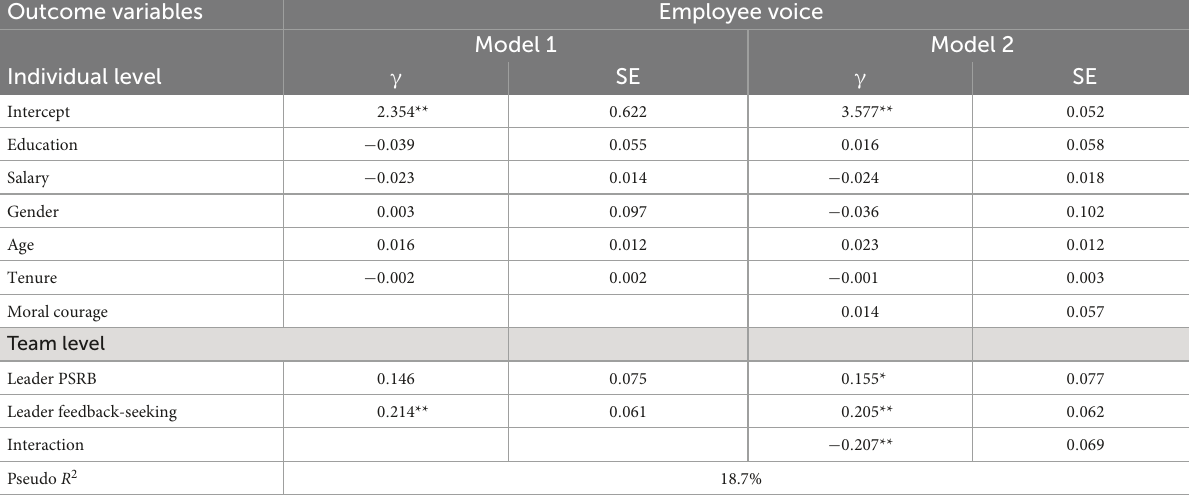
TABLE 5 The results of cross-level analysis.